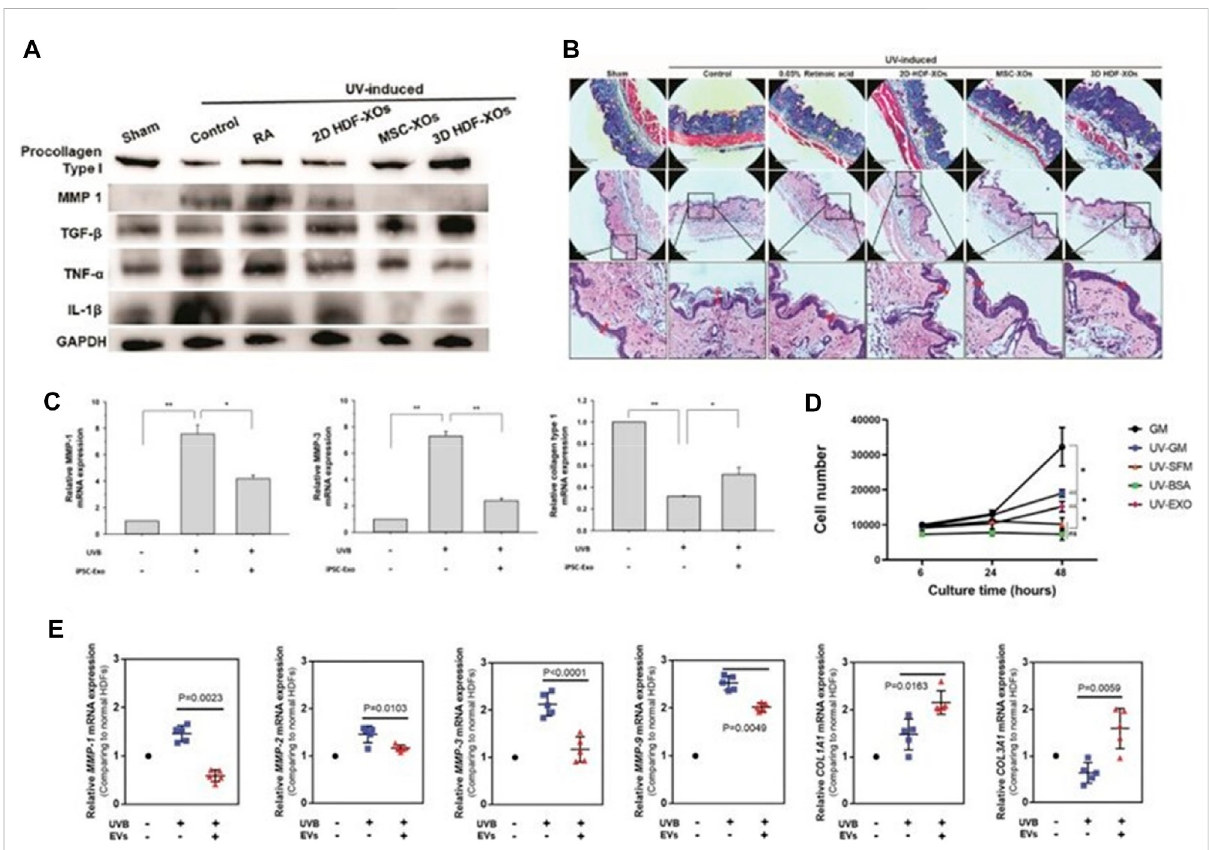
FIGURE 7 The mechanism for exosome regulation of MMPs. (A) Western blot of dorsal skin of different groups. (B) Masson ’ s Trichrome staining and Corresponding H & E staining. scale bar: 290 μ m (Hu et al., 2019). (C) The mRNA expression levels of MMP-1, MMP-3 and collagen type I